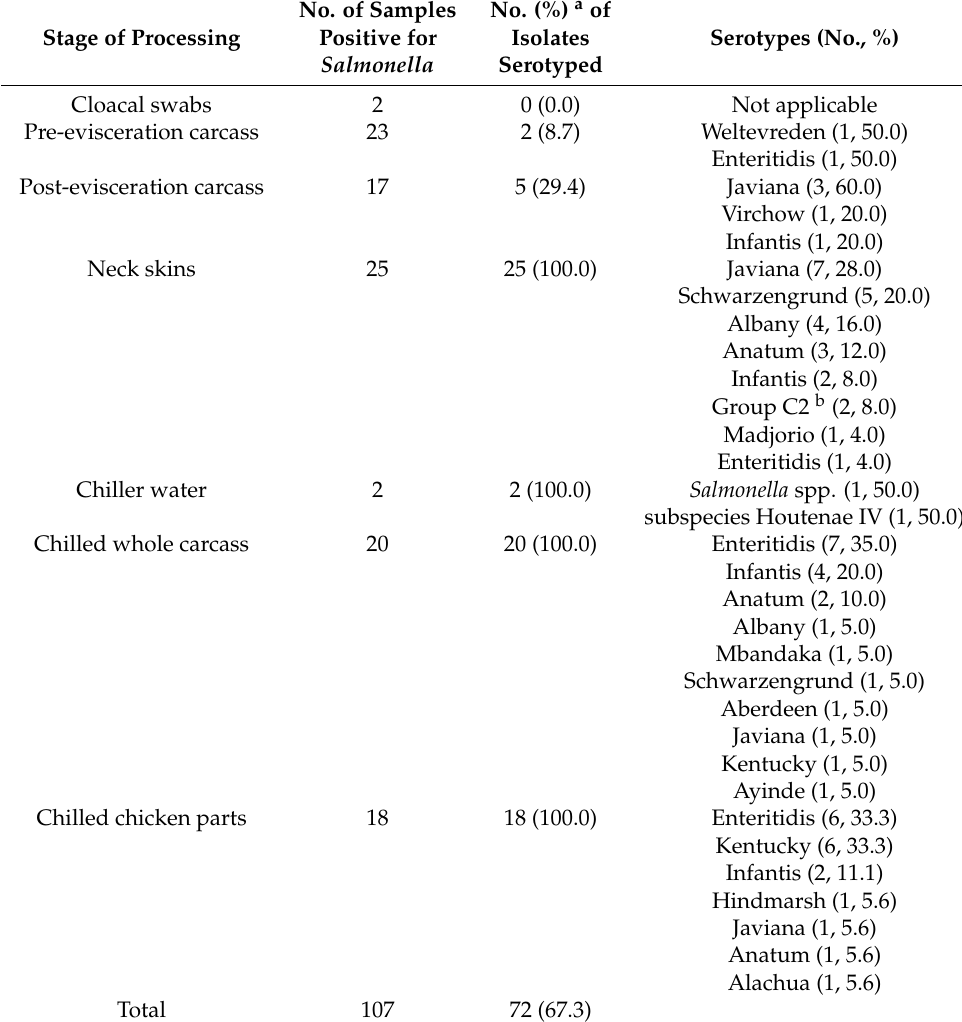
Table 5. Salmonella serotypes isolated from different types of